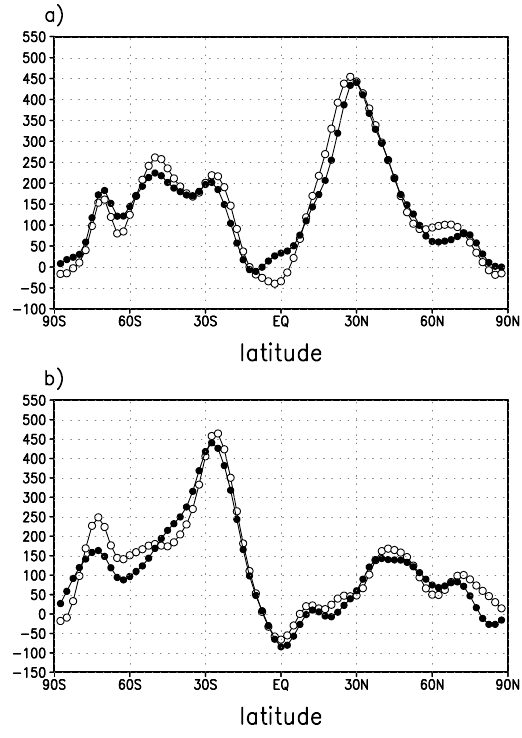
Fig. 10. Latitudinal variation of Eady growth rate for: (a) January 1996 and January 1998, and (b) July 1995 and July 1997. El Ni˜no event 1997–1998 is indicated by open circles and La Ni˜na 1995– 1996 is represented by closed circles. Units, day − 1 .